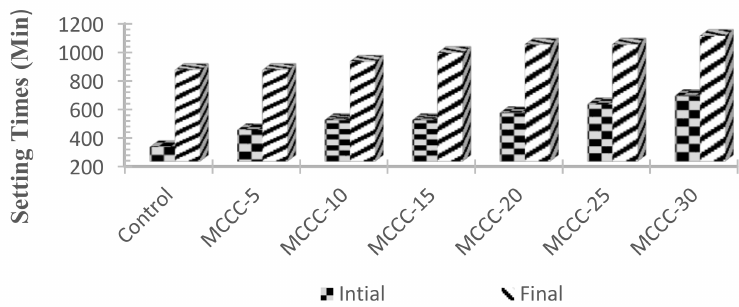
Figure 8. Initial and finals setting times of MCC-based HPC mortar.